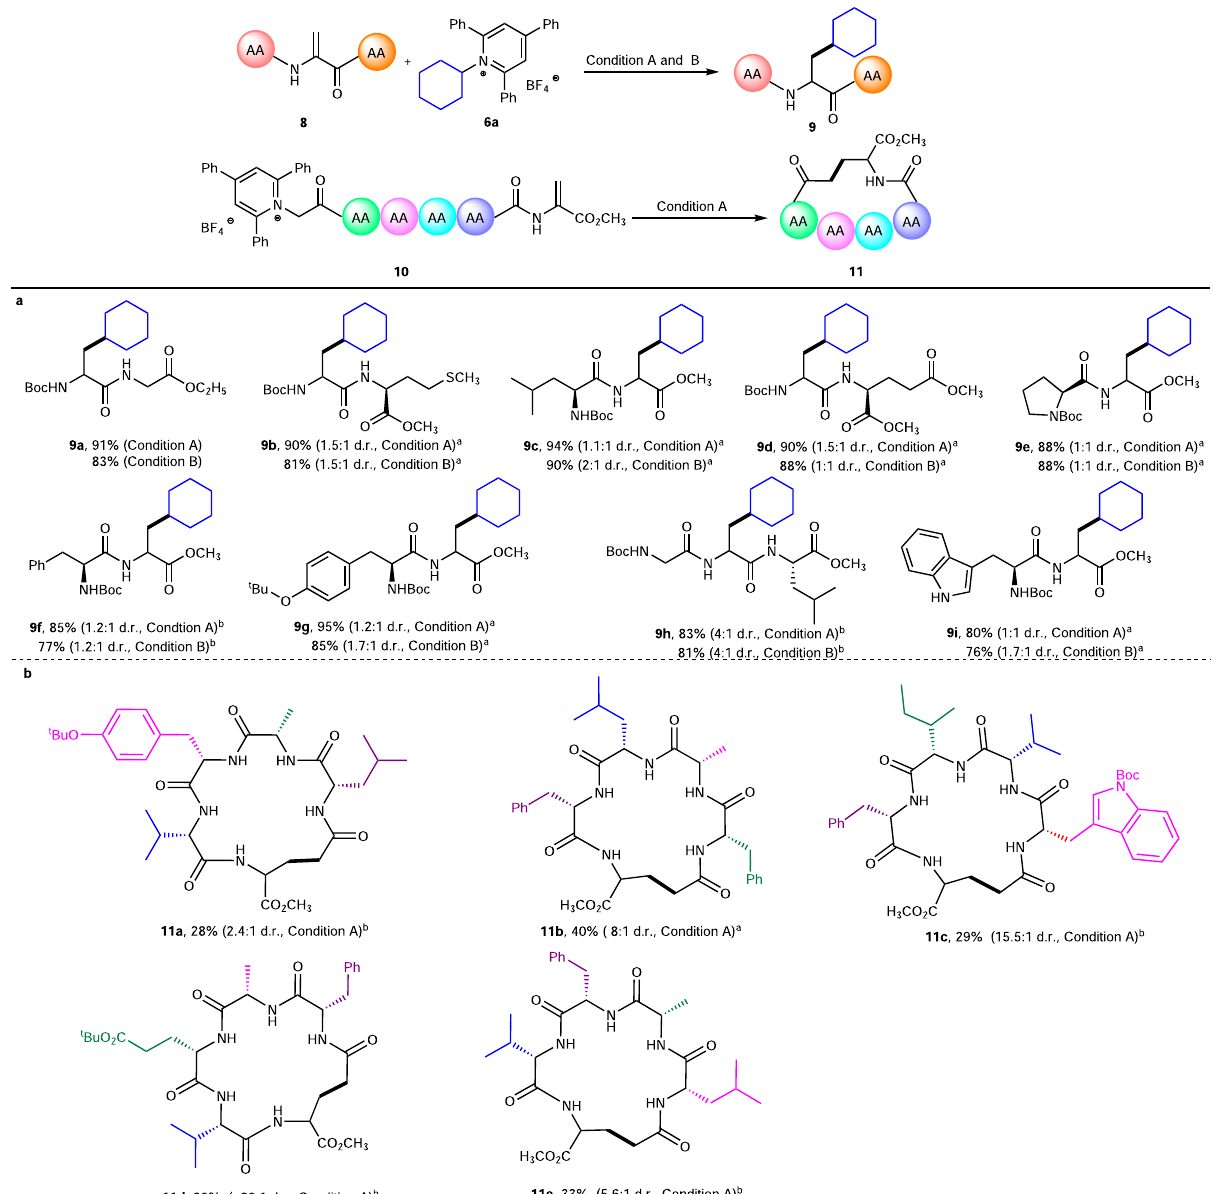
Fig. 3 Modi fi cation and macrocyclization of peptides. a Diastereomers were measured by 1 H NMR. b Diastereomers were measured by HPLC. a Isolated yield on 0.2 mmol scale (condition A and condition B). b For 11a and 11c – 11e , isolated yields on 0.02 mmol under condition A; for 11b , isolated yield on 0.05 mmol under condition